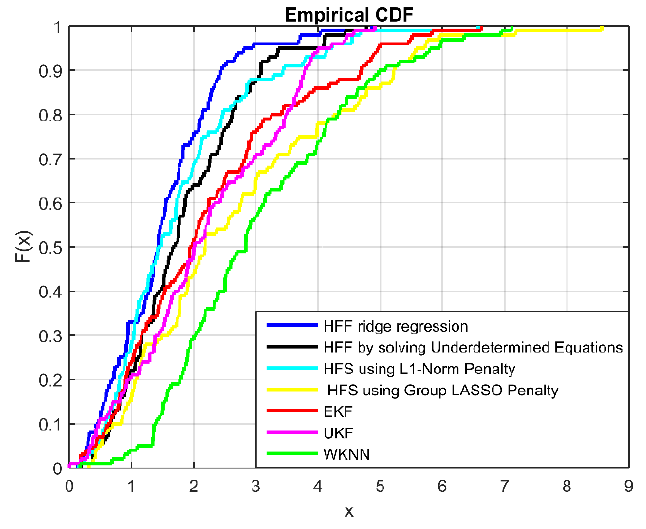
Sensors 2018 , 18 , x FOR PEER REVIEW 12 of 17 Figure 4. Comparison of Localization results in term of CDF. Figure 4. Comparison of Localization results in term of CDF.